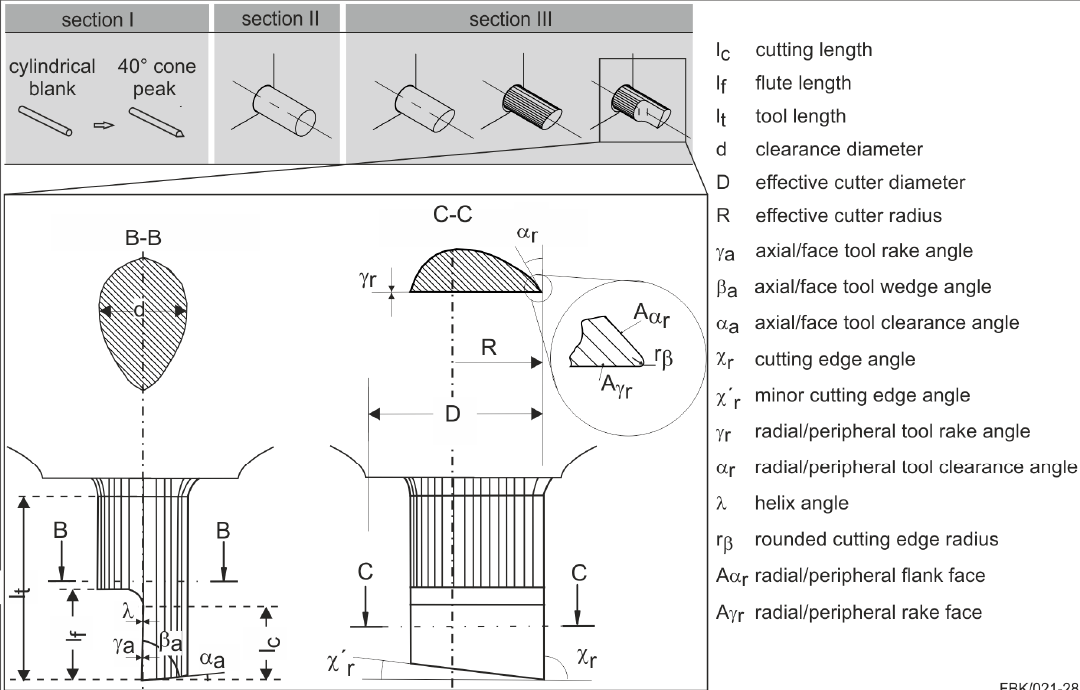
Figure 3. Schematic of the Tool grinding process and nomenclature after [15,17].